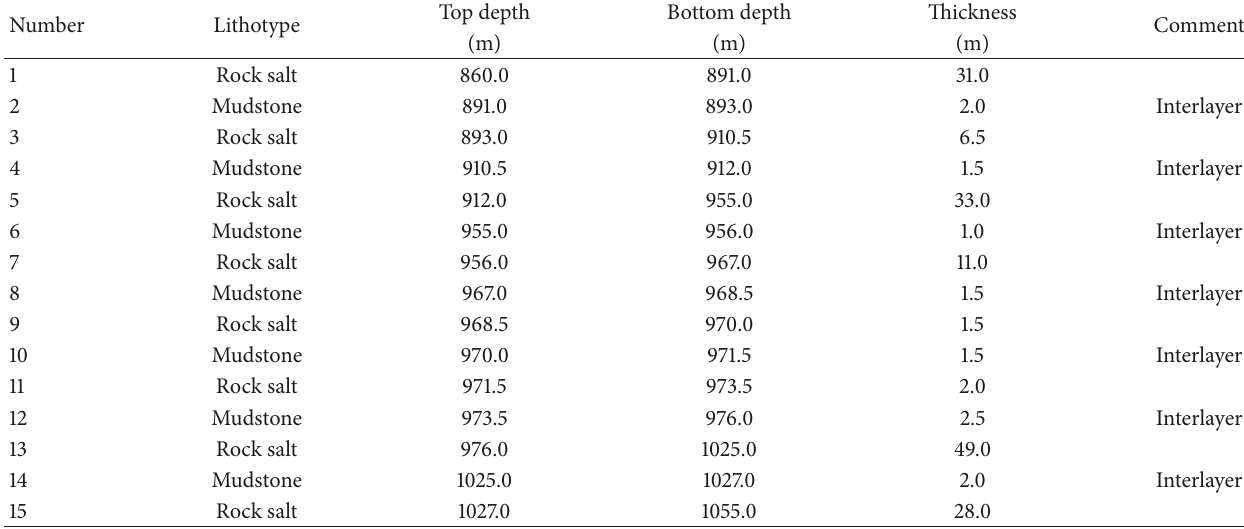
Table 3: Stratum distribution of Well M1# Ef 4 .